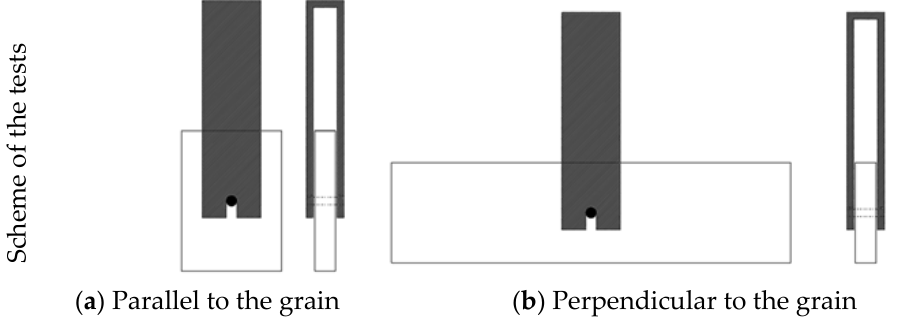
Figure 1. Scheme of experimental tests.